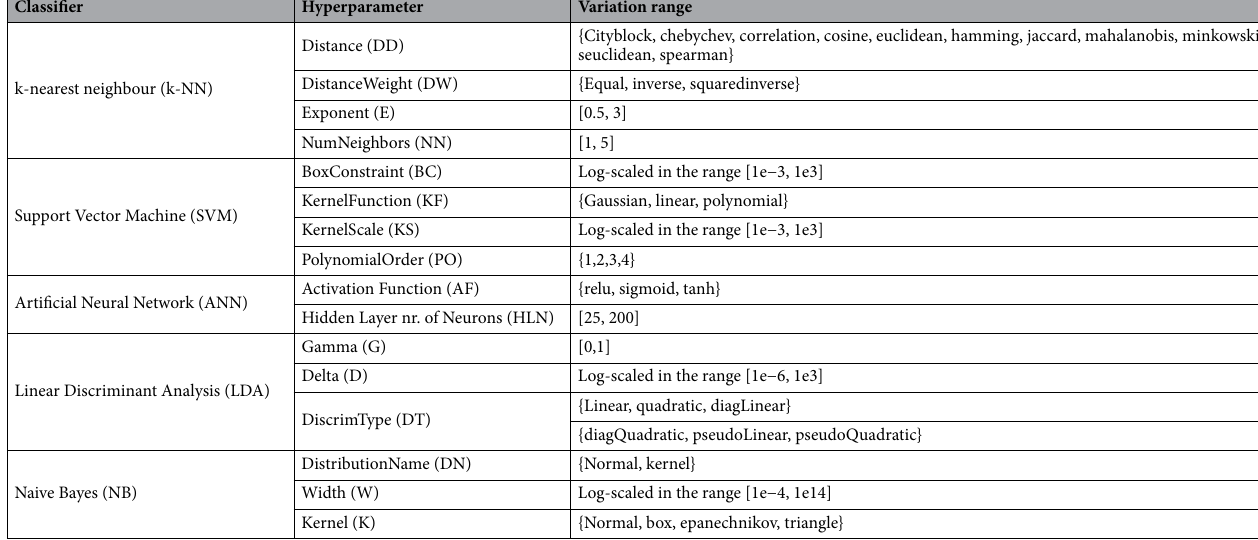
Table 2. Classifier optimized hyperparameters and variation range.